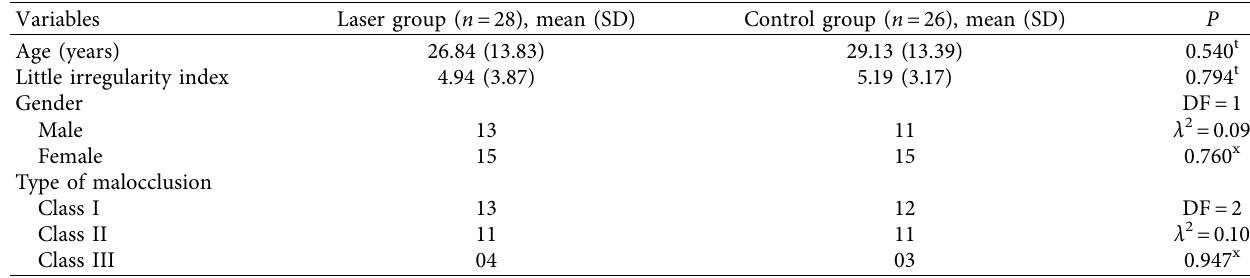
Table 1: Intergroup comparability.